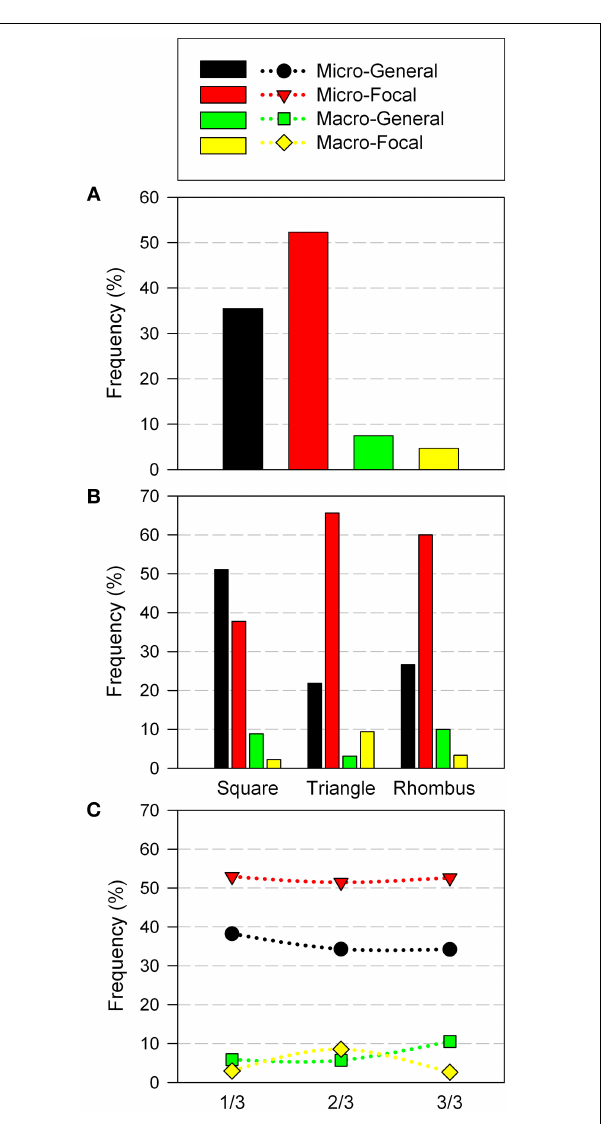
FIGURE 6 | Sensorimotor Strategies distribution in Experiment 2 according: general use (A) geometric shape (B) and trial order (C). The figures report the cumulative percent of strategies of all